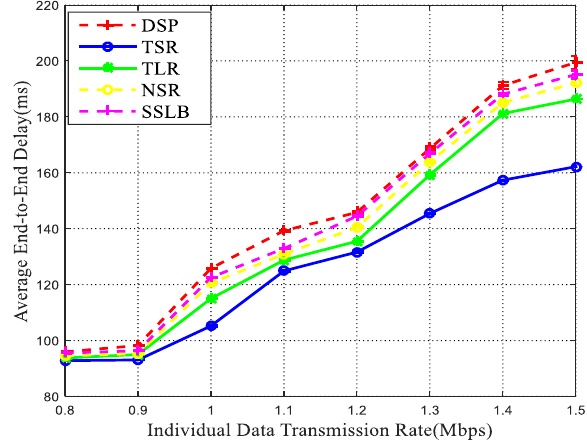
Figure 7. End-to-end delay vs. transmission rate.